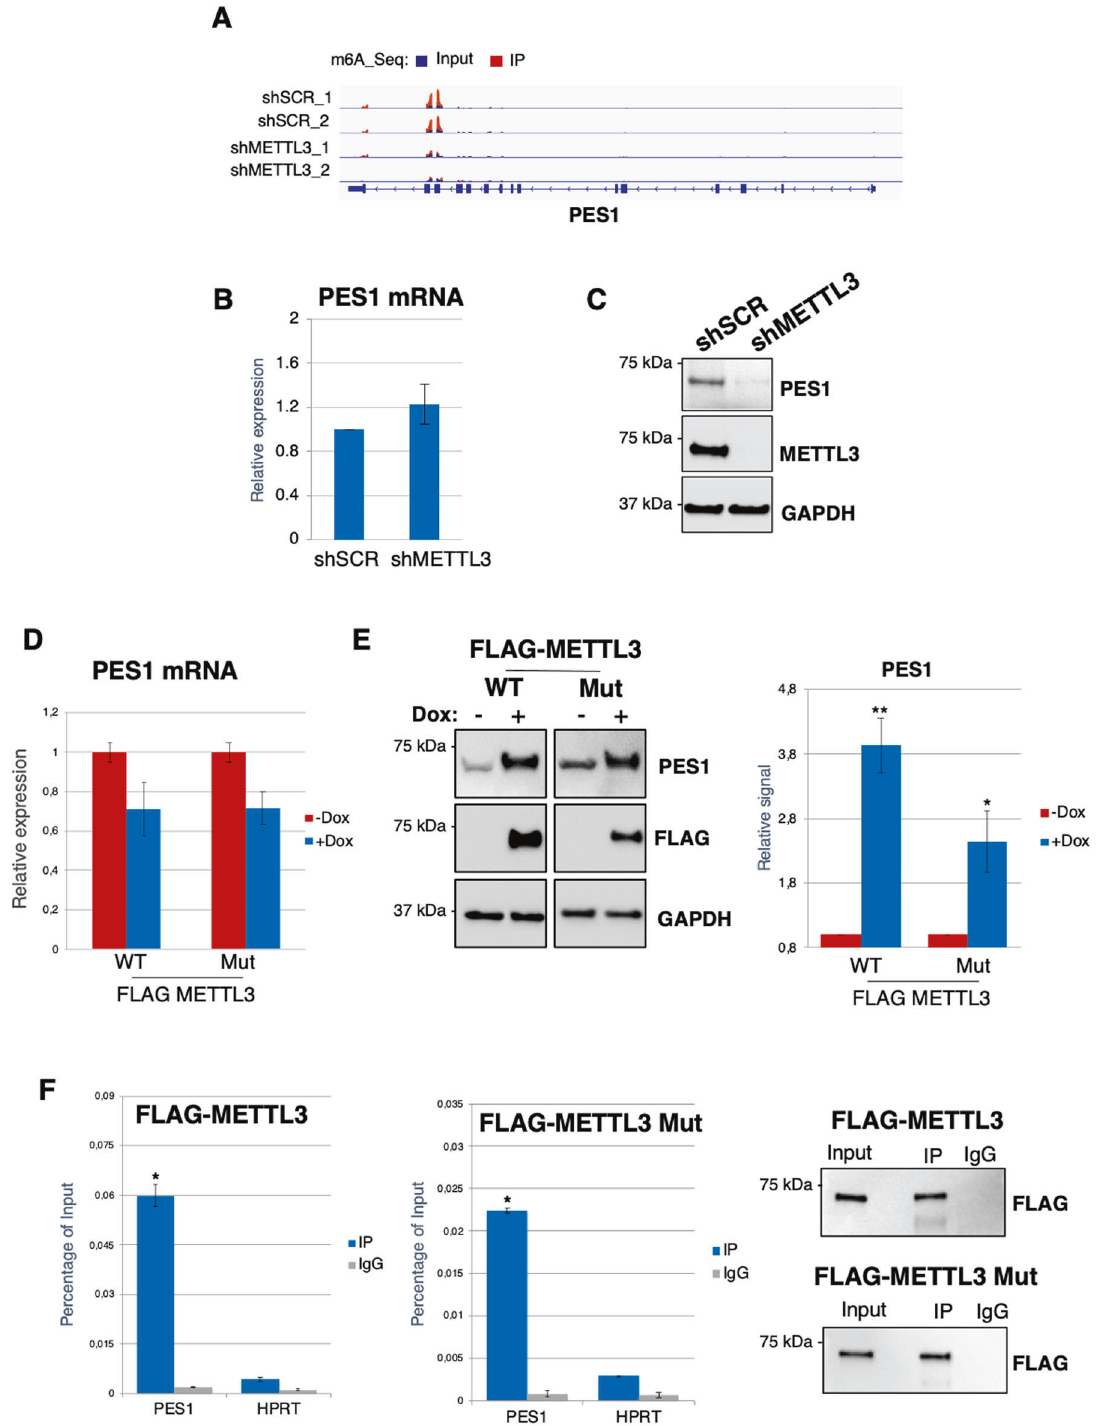
Fig. 7 METTL3 regulates PES1 translation. A The m 6 A abundances on PES1 transcripts in shMETTL3 and control shSCR cells as detected by m 6 A-seq. B Expression levels of PES1 mRNAs in shSCR and shMETTL3 cells. Values are normalized against ACTB and expressed as relative quantities with respect to shSCR cells set to a value of 1; n = 3. C Western blot analysis in shMETTL3 and shSCR K562 transduced cells. Protein levels were analyzed 48 h after puromycin selection. D qRT-PCR analysis of PES1 mRNA expression in K562 cells overexpressing METTL3 and METTL3 catalytic inactive mutant (METTL3 Mut). E Western blot analysis of PES1 and METTL3 in the same cell of panel D . Densitometric analysis of PES1/GAPDH ratio from biological replicates ( n = 3) is shown below with s.e.m. F Left panel, qRT-PCR of CLIP experiments performed with FLAG-METTL3 and FLAG-METTL3 Mut from cytoplasmic extract of K562 cells. Right panel, representative Western blot analysis of FLAG-tagged proteins IP vs Input (1%) and control IgG. In all panels, relative RNA quantity in the bars is represented as the mean of the fold change with standard deviation. Ratio of each sample versus its experimental control was tested by two tailed Student ’ s t -test. * p < 0.05, ** p < 0.01.